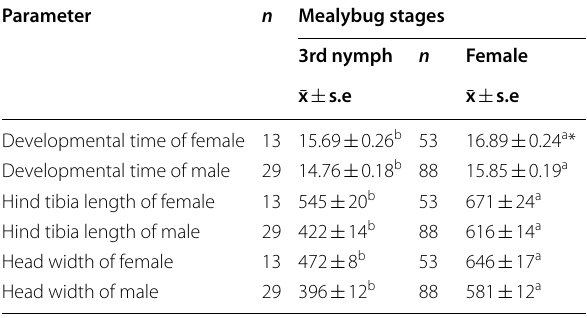
*Means within a row followed by different lowercase letters are significantly different (Mann–Whitney U test, P ≤